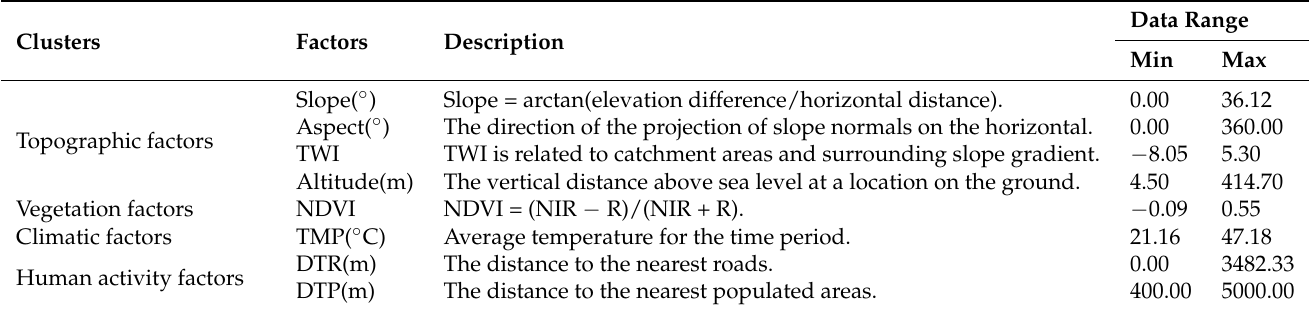
Table 1. Classification of the forest fire influencing